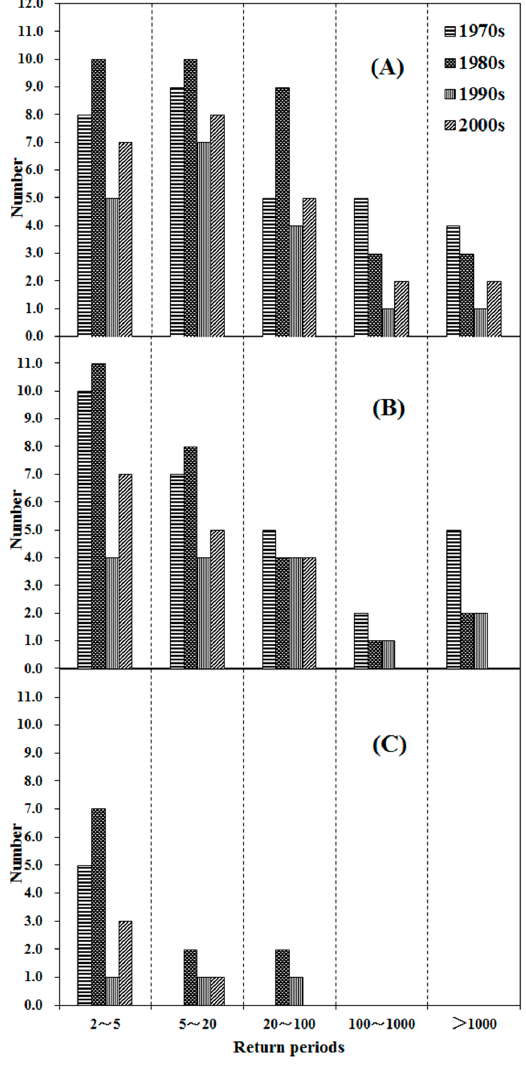
Figure 6. The average annual number of flood events under different return periods, i.e., 2 to 5, 5 to 20, 20 to 100, 100 to 1000, and >1000 years, for various decades (1970s, 1980s, 1990s, and 2000s) in the flood season ( A ), wet season ( B ), and dry season ( C ).